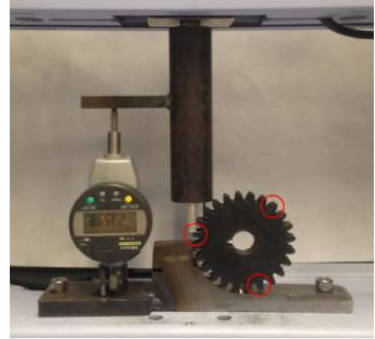
Figure 29. Spur gear sti ff ness test for